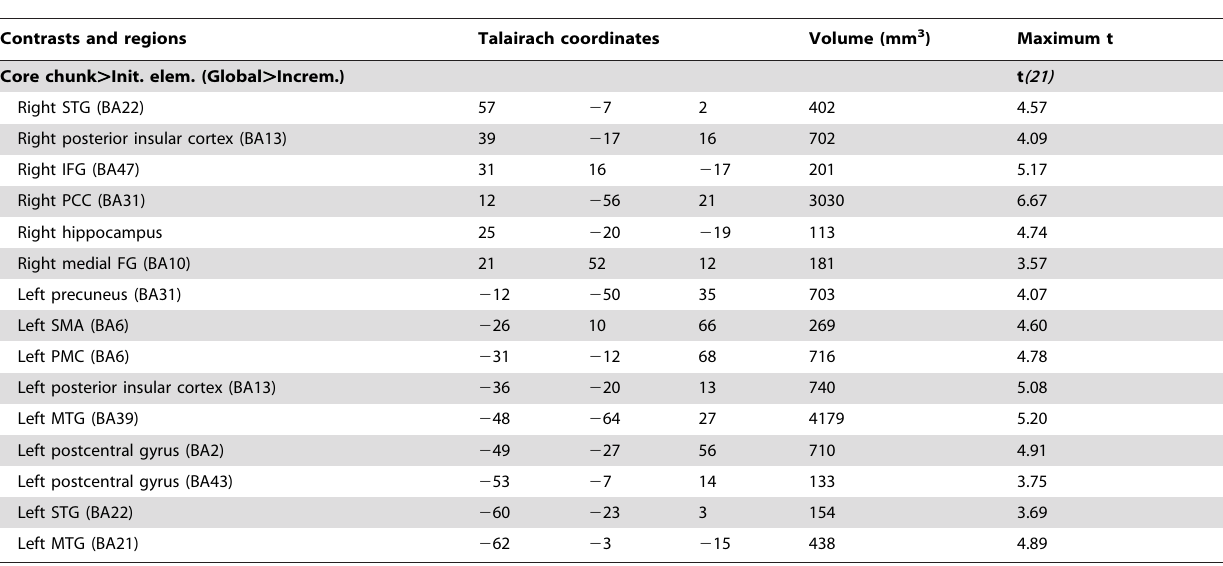
Table 4. Brain regions activated by contrast [ Core chunk . Initial element ] more in Global than in Incremental group.